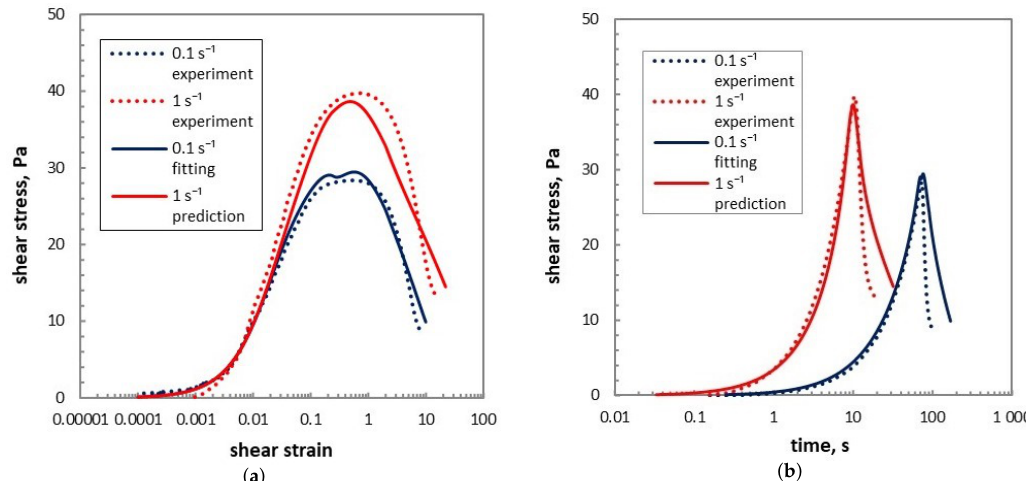
Figure 12. Model predictions of shear stress as a function of shear strain and of time using a relaxational time history of shear rate Equation (21) (with the fitting values in Table 2: ( a ) shear stress as a function of shear strain; ( b ) shear stress as a function of